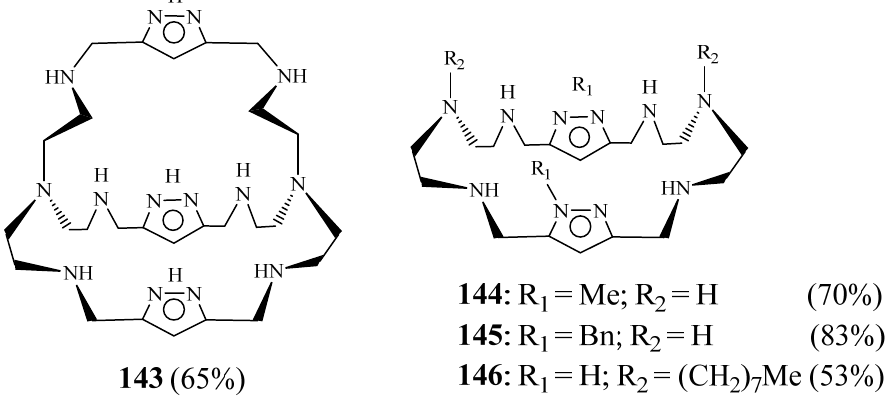
Figure 39. Structure of macrocycles 143 − 146. (Reprinted with permission from ref. [61]. Copyright 2012 American Chemical Societ).